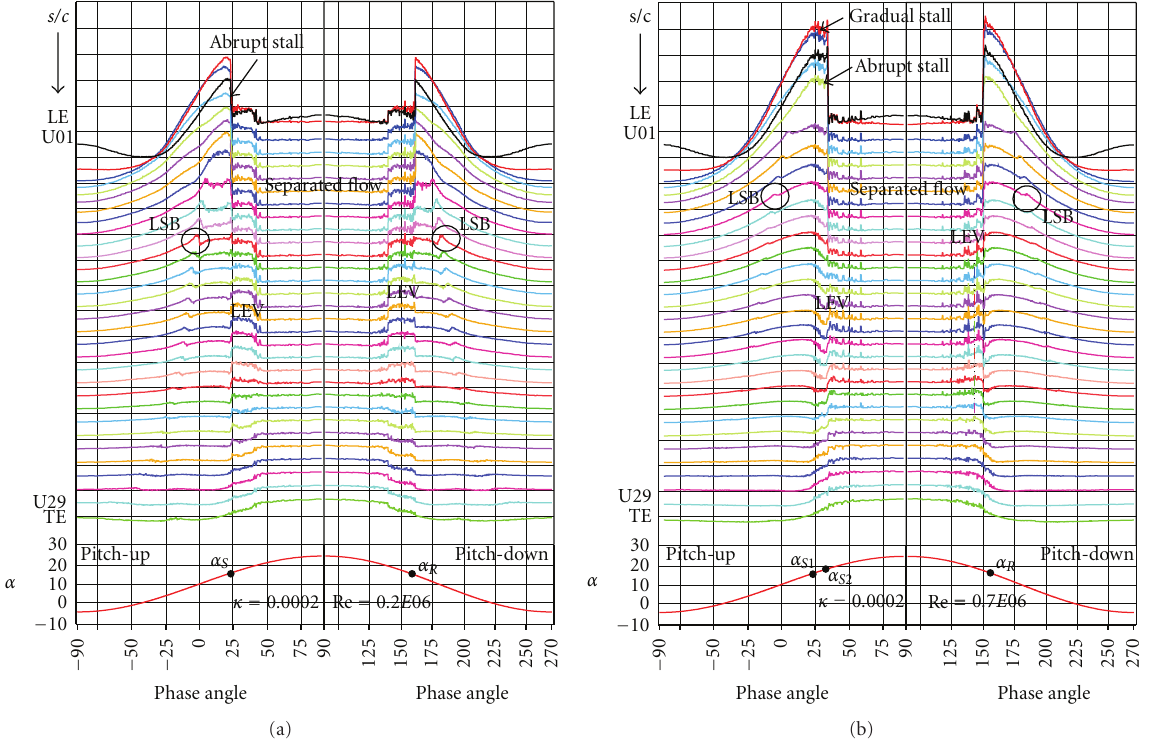
Figure 14: Time series C Pu distribution for κ = 0 . 002 at Re = 0 . 2 E 06 and 0.7 E